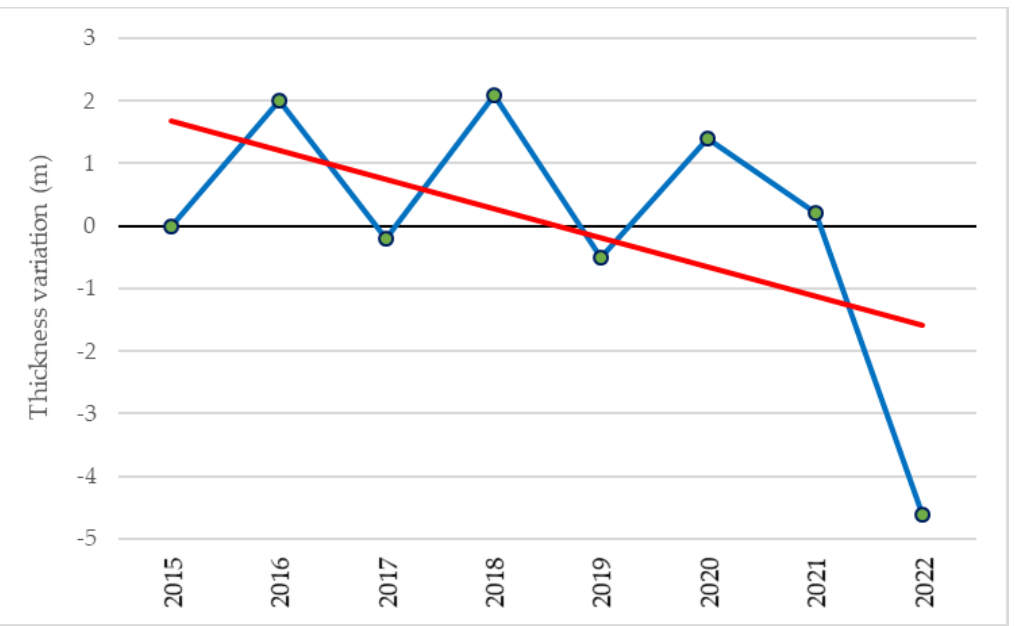
Figure 17. Evolution of the Infierno Glacier (Glacier lateral monitoring station). Period 2016 – 2022. Thickness variation, data in meters. References on position in 2015 and trend line (red).